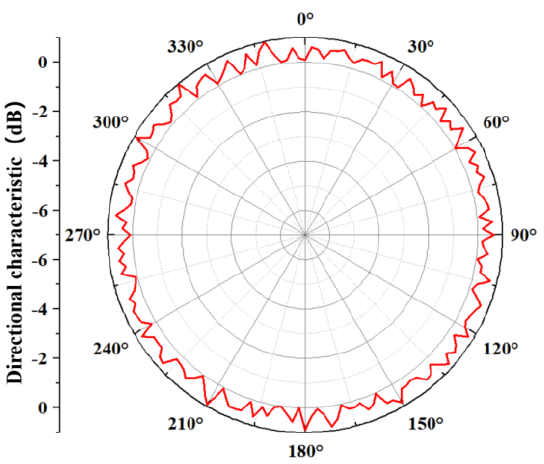
Figure 16. Directivity curve of transducer in the water.